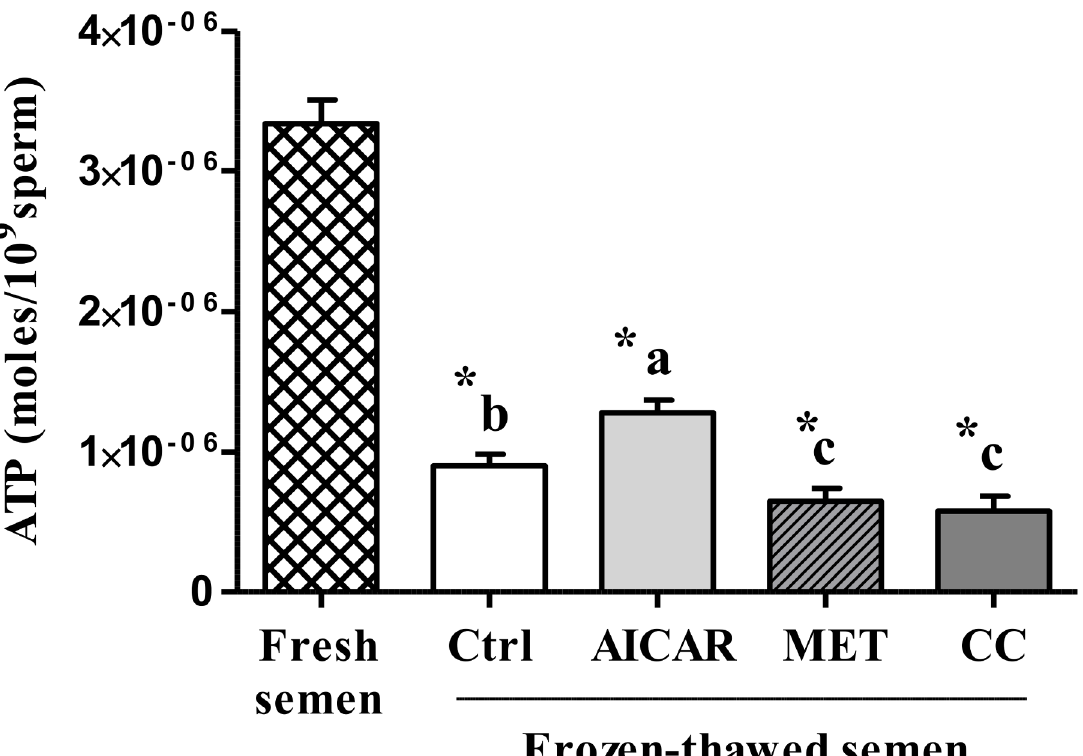
Fig 4. Effect of AMPK inhibitor CC and activators AICAR and MET on ATP concentration in frozen-thawed sperm. Sperm were treated in the presence of an AMPK activator (2mM AICAR (in light gray) or 1mM MET (in diagonals)) or an AMPK inhibitor (5 μ M CC (in dark gray)) or Control (Ctrl, in white); Fresh semen (checkered pattern). Values represent means ± SEM from 6 different experiments (4 samples/experiment). Different superscripts indicate significant differences between Ctrl and treatments (AICAR, MET or CC) in frozen-thawed semen ( a,b,c , P < 0.05). Asterisks indicate statistically significant differences between fresh and frozen-thawed semen ( * , P <